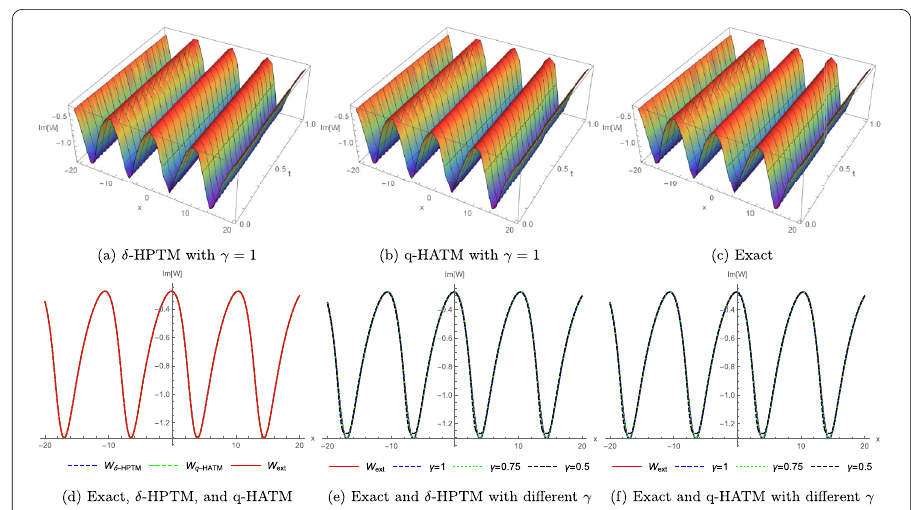
Figure 6 The plots of the imaginary parts of δ -HPTM, q-HATM, and exact solution for Example 3